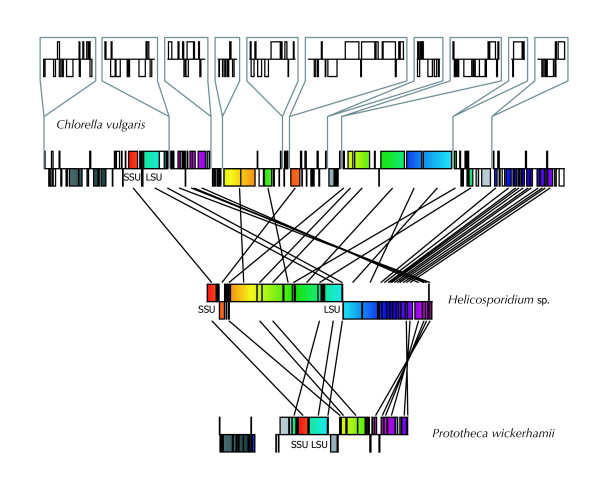
Gene order comparisons between trebouxiophyte plastid genomes. Genomes are drawn to scale. Coloured boxes represent identity with genes found in Helicosporidium sp., grey-shaded boxes represent identity between genes found in Chlorella vulgaris and Prototheca wickerhamii, and open boxes represent genes found only in C. vulgaris. Segments of the C. vulgaris genome that have been completely lost in Helicosporidium are shown in call-out boxes above the remainder of the genome. Straight lines join the genomes at the center points of protein coding and rRNA genes. For orientation, the rRNA genes are indicated.